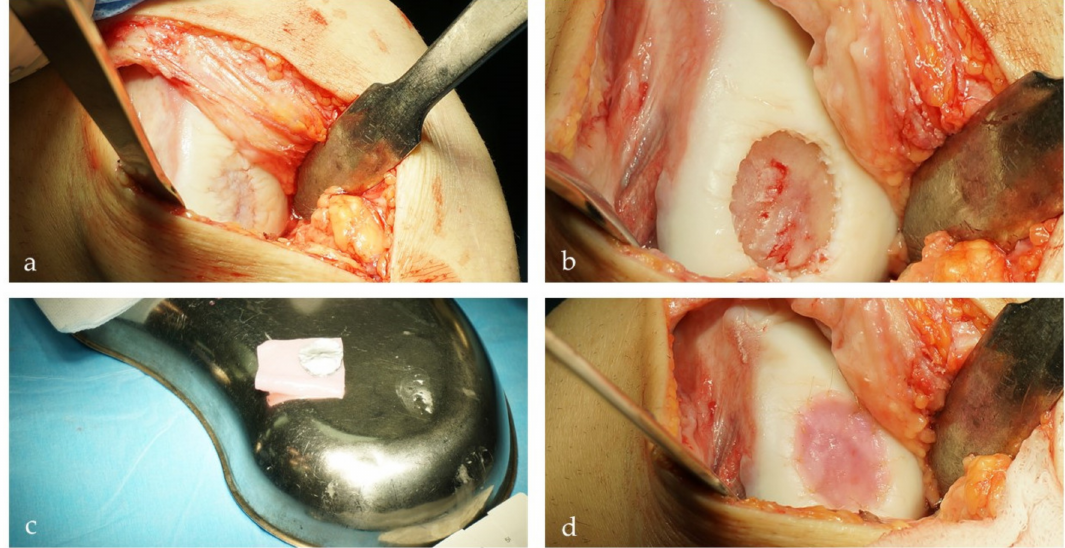
Figure 4. Transplantation of nasal-chondrocyte engineered construct for the treatment of the full-thickness cartilage defect in a 28-year-old athlete [19]. ( a ) Exposure of the full-thickness cartilage defect of the medial femoral condyle via mini- arthrotomy. ( b ) Debridement of the cartilage lesion to remove the damaged cartilage and establish adequate shouldering of the lesion. ( c ) Tissue-engineered cartilage cut to the right shape and ready for implantation. ( d ) Tissue-engineered cartilage inserted in the cartilage defect and secured by 5–0 monofilament absorbable